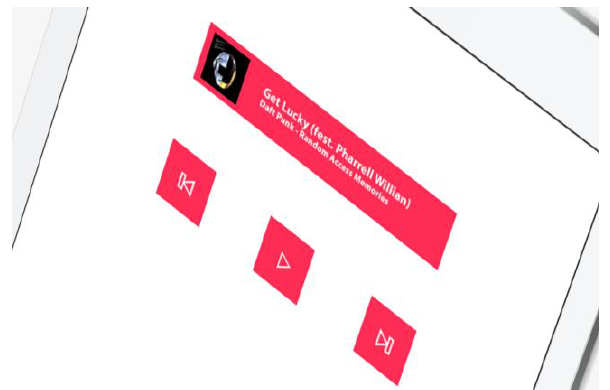
Figure 14. Demo music app.